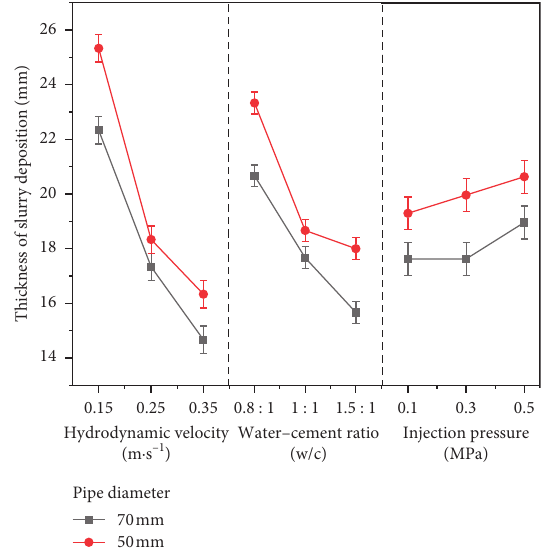
Figure 6: Influences of various factors on the proportion of the retained slurry thickness.